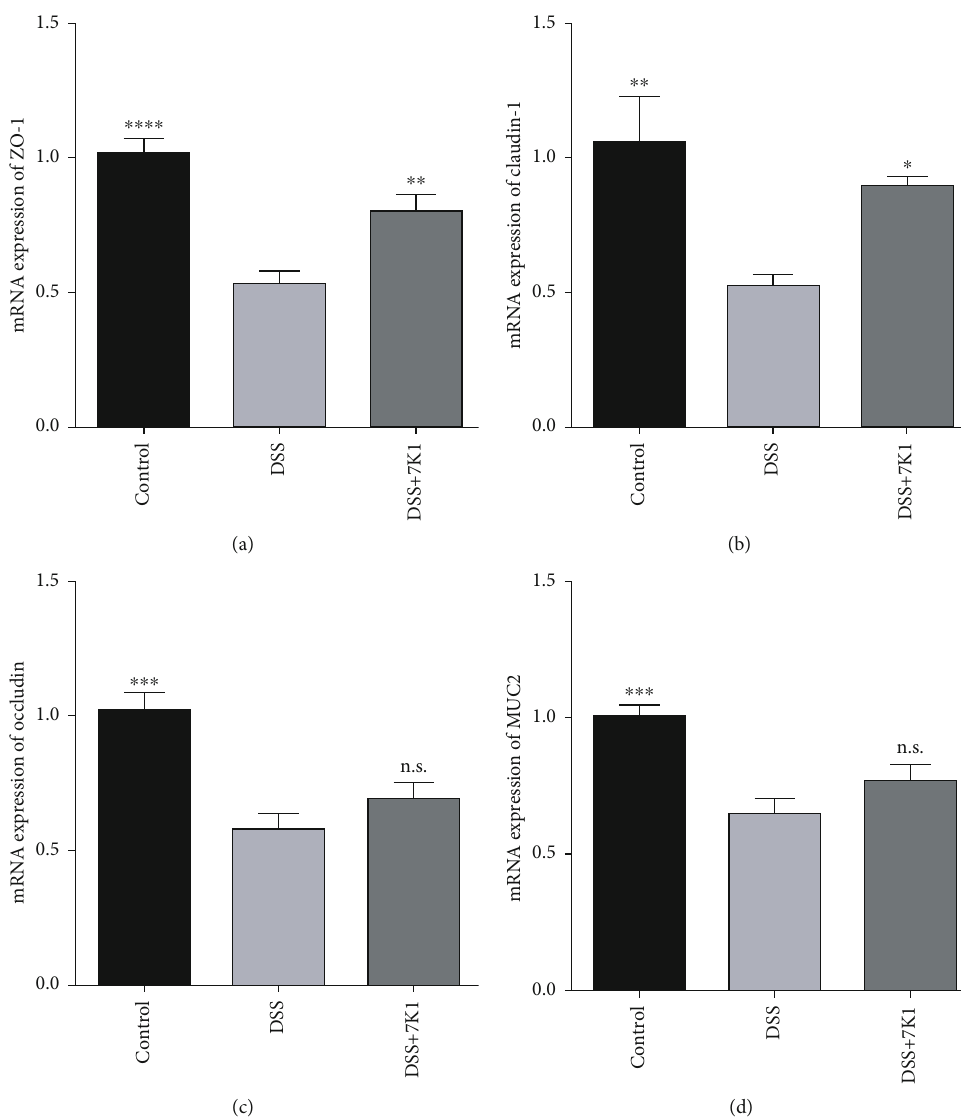
Figure 7: E ff ects of Bacteroides vulgatus on the intestinal barrier of mice. (a) ZO-1. (b) Claudin-1. (c) Occludin. (d) MUC2. Six mice per